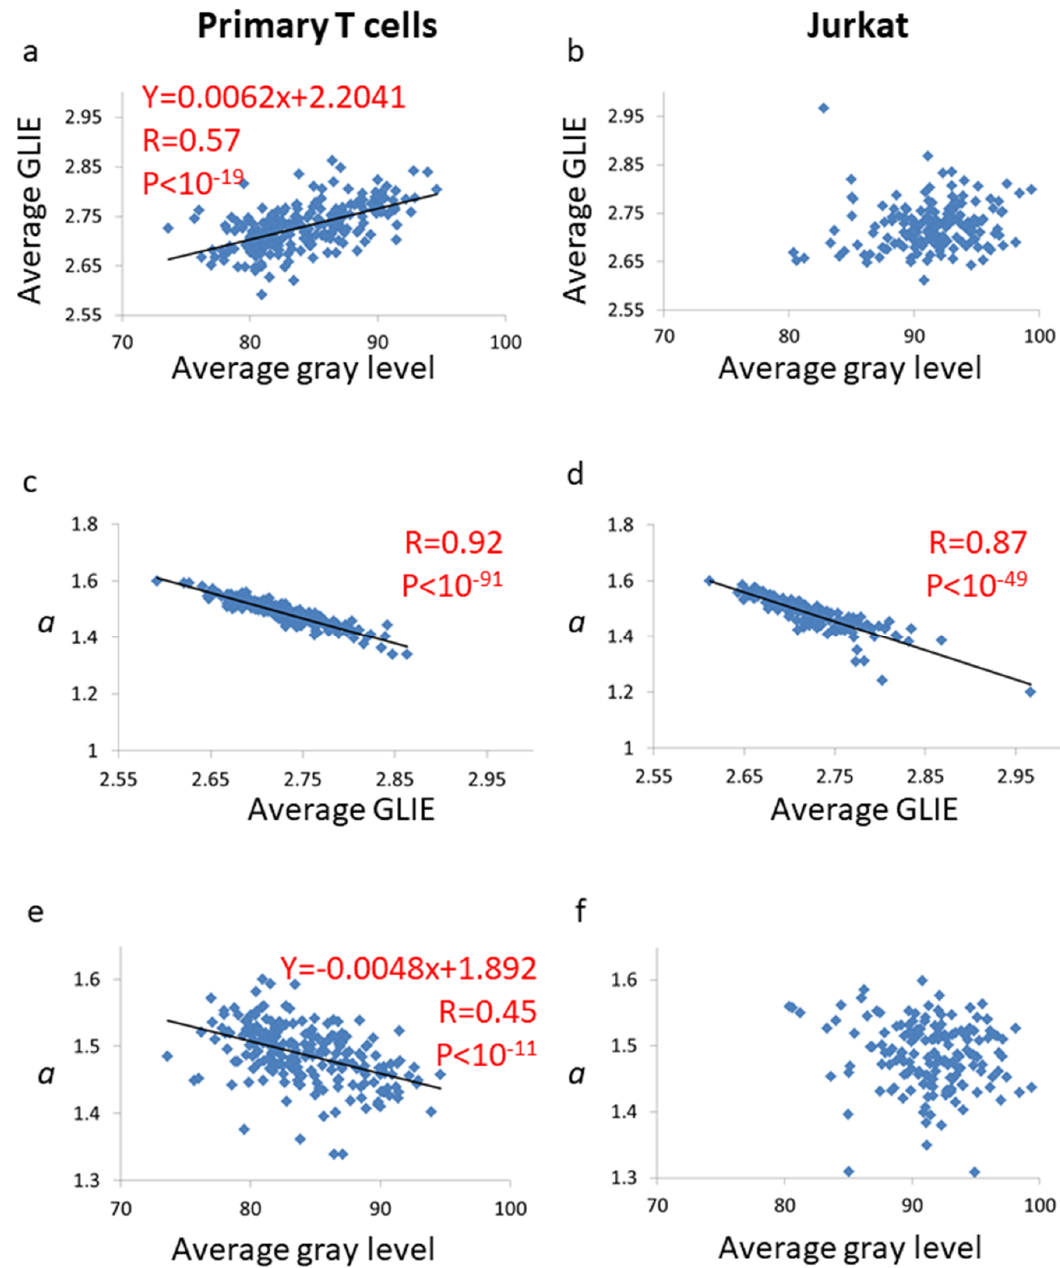
Figure 10. The correlations between average gray level, average GLIE and a parameters in primary T cells (n = 219) and in Jurkat cells (n = 161). The correlation between average gray level and average GLIE values in primary T cells ( a ) and in Jurkat cells ( b ). The correlation between average GLIE values and a parameter in primary T cells ( c ) and in Jurkat cells ( d ). The correlation between average gray level values and a parameter in primary T cells ( e ) and in Jurkat cells ( f ). The linear regression formulas are presented in panels a and e . R- and p -values of each correlation are presented.